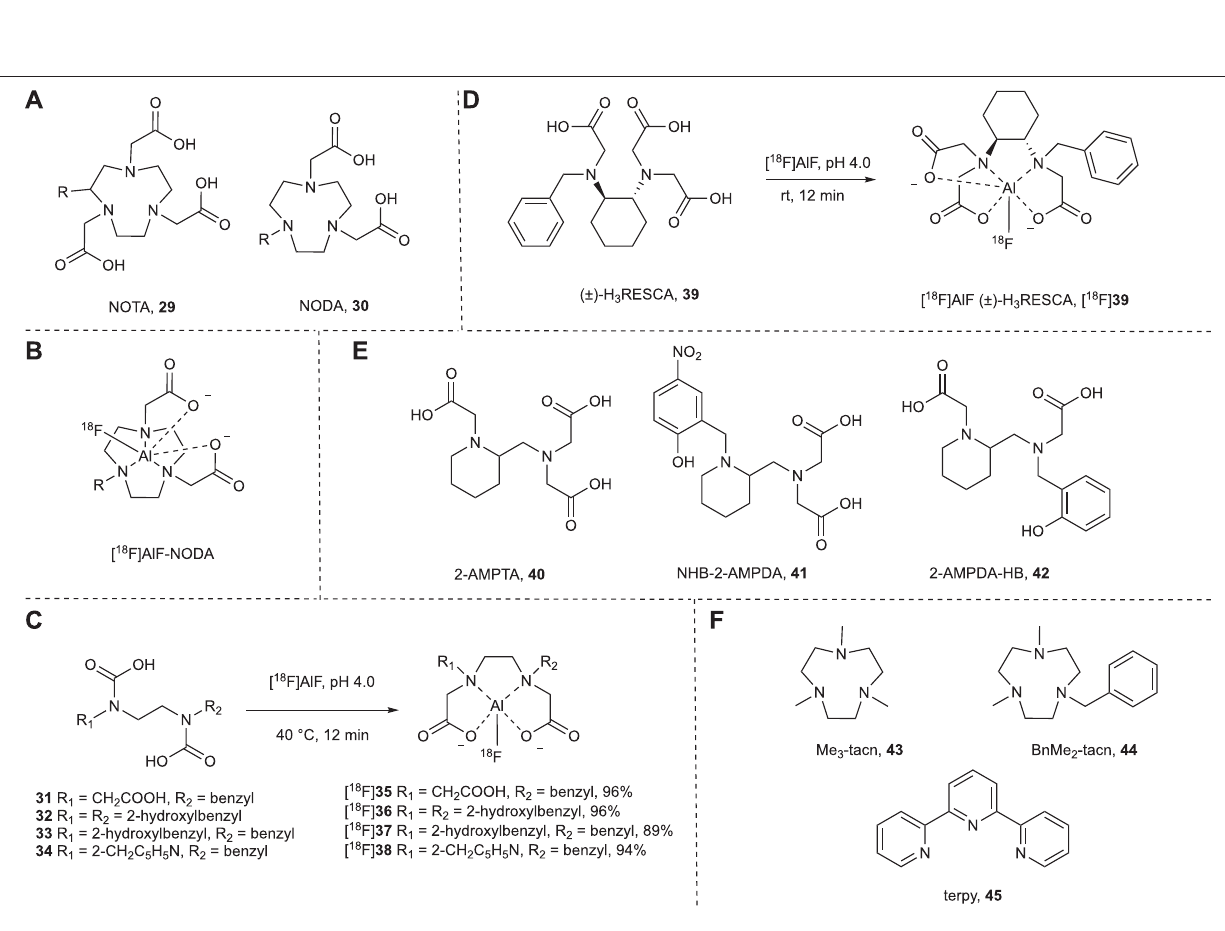
FIGURE 4 | [ 18 F]Tri fl uoroborates can be synthesized via 19 F/ 18 F isotopic exchange at low pH and room temperature in high yields in only 20